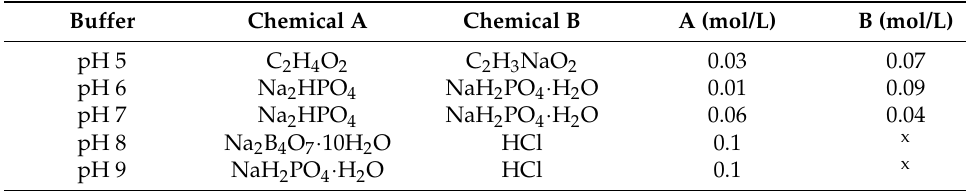
Table 2. Composition of the used 0.1 M buffer systems.